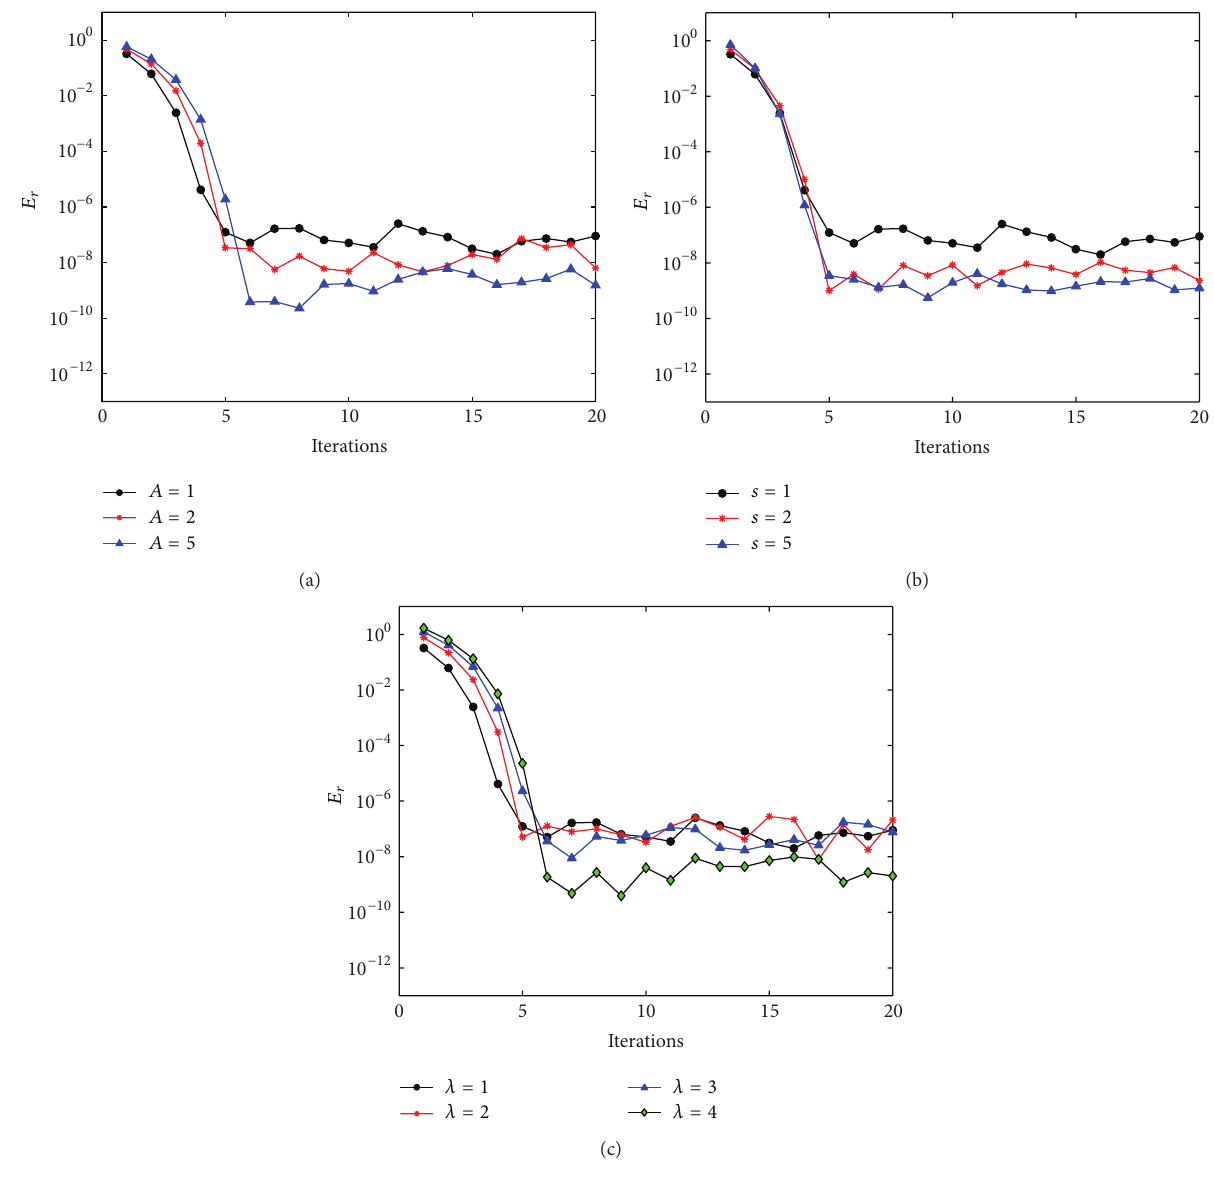
Figure 3: Effect of varying parameters on the SQLM error 𝐸 𝑟